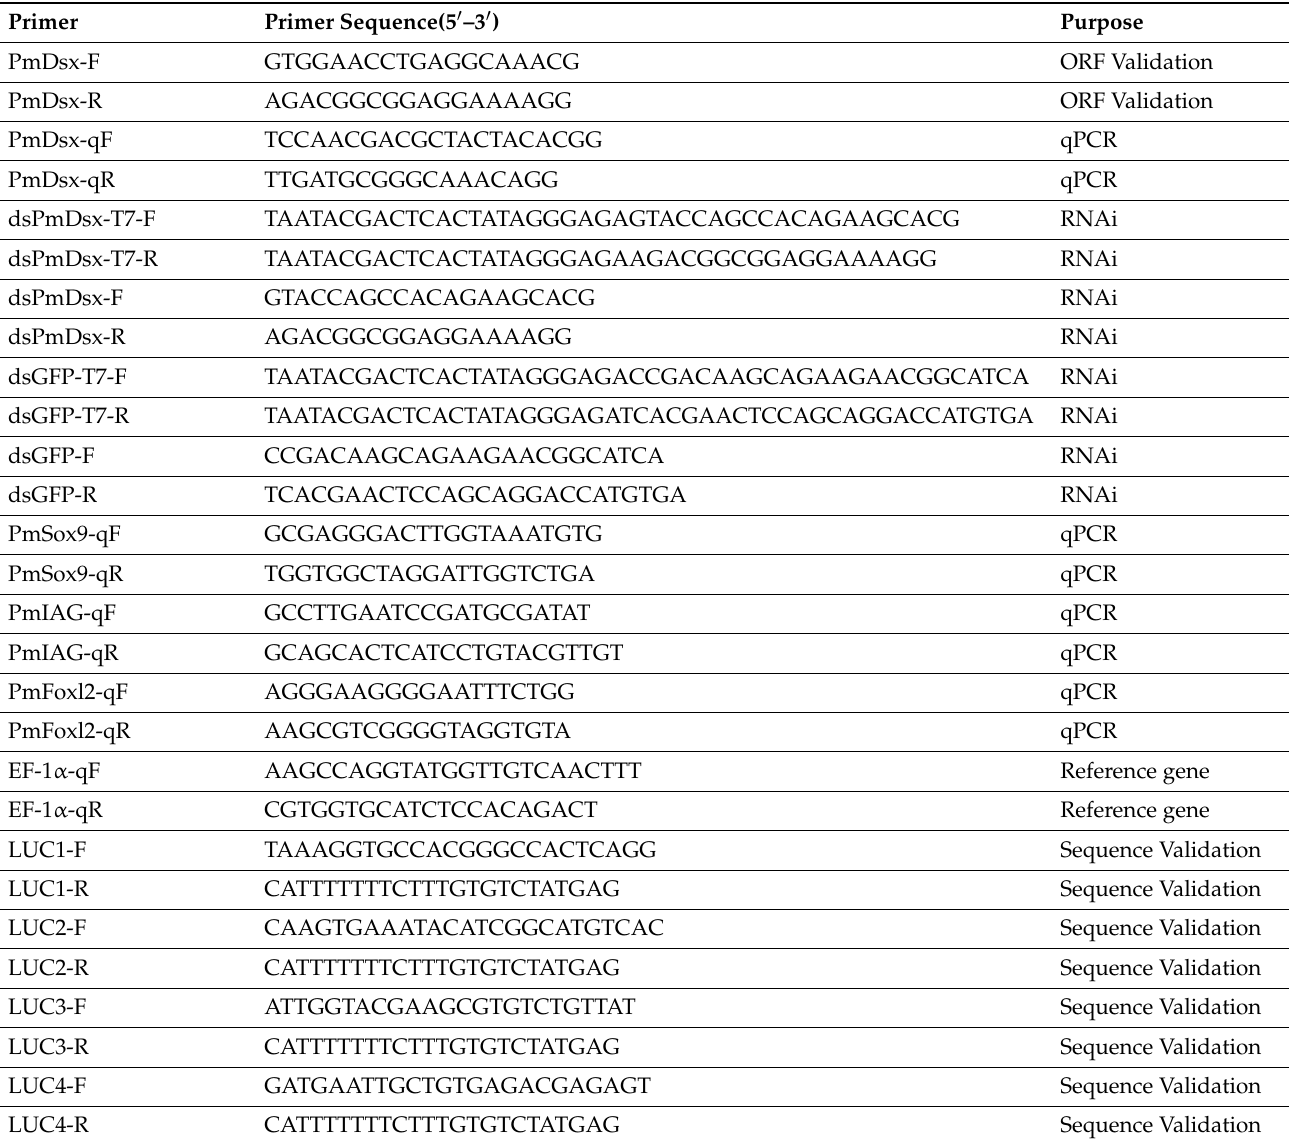
Figure 8. Amplification of different segments of the P. monodon IAG promoter sequence. The PCR amplification products were verified and purified by agarose gel electrophoresis. Table 1. Primers and sequences used in the